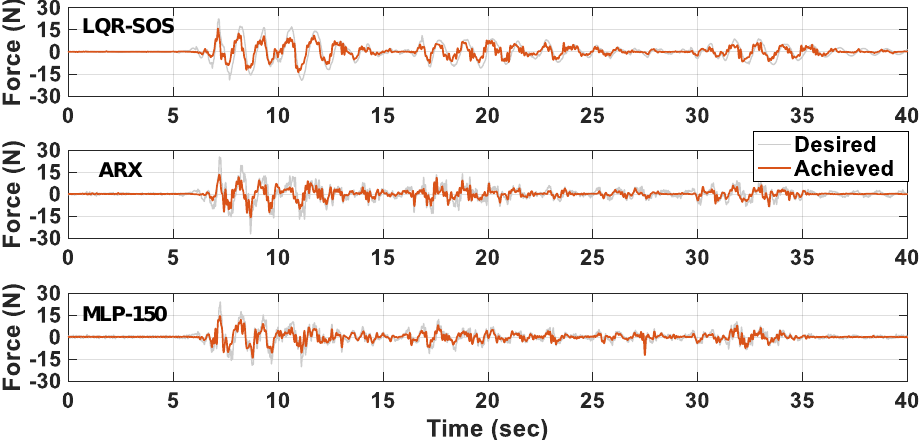
Figure 14. Time histories of the desired and achieved control force of the three controllers.